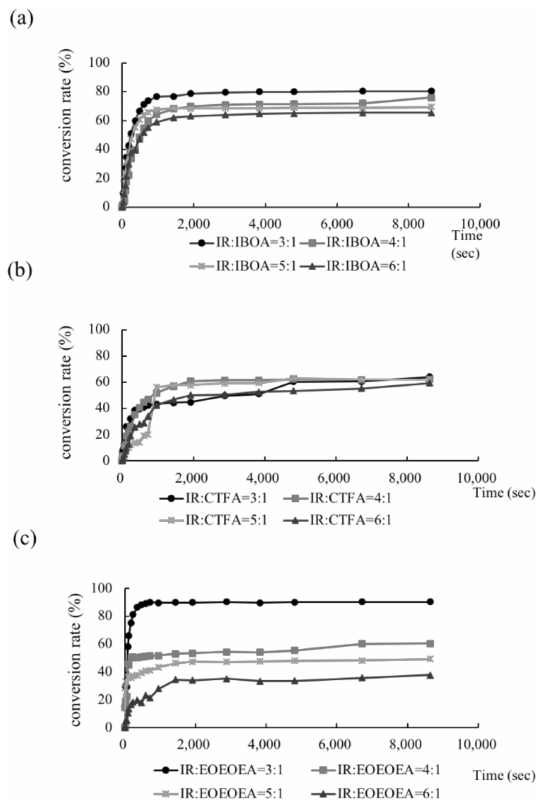
Figure 3. Degree of Conversion rate of cis -polyisoprene (IR) with different dilute monomers. ( a ) IR/IBOA, ( b ) IR/CTFA, ( c ) IR/EOEOEA. The ratios of polyisoprene (IR) and dilute monomers are 3:1, 4:1, 5:1, and